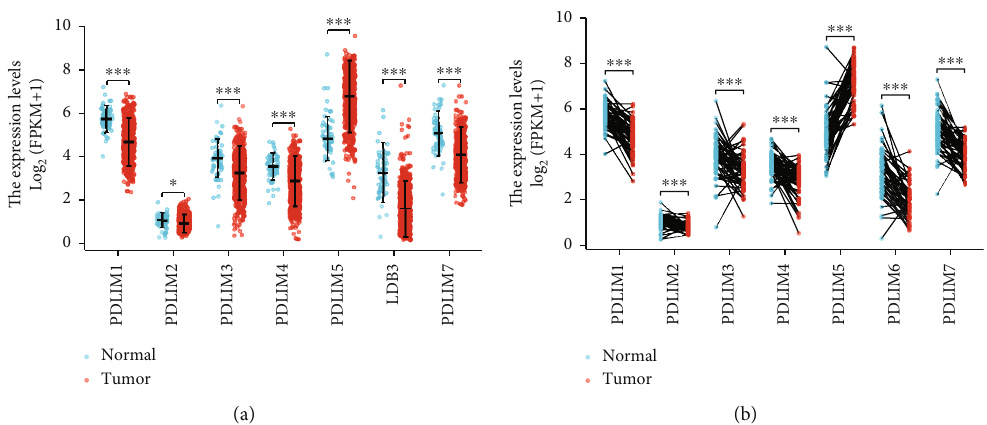
Figure 1: Expression patterns of PDLIMs in prostate cancer. (a) The expression of PDLIM family genes in prostate cancer tissues ( n = 499 ) compared to normal adjacent tissues ( n = 42 ) in in TCGA-PRAD cohort. (b) Expression of PDLIM family genes in paired prostate cancer tissues and normal tissues (52 vs. 52). ∗ P < 0 : 05 , ∗∗ P < 0 : 01 , and ∗∗∗ P < 0 : 0001